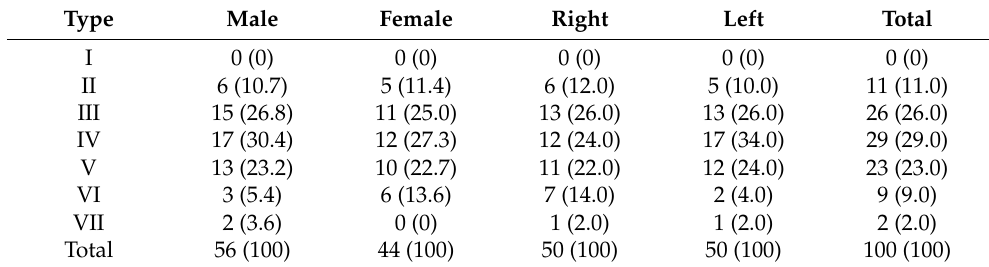
Table 3. Differences in laterality and sex for each type.